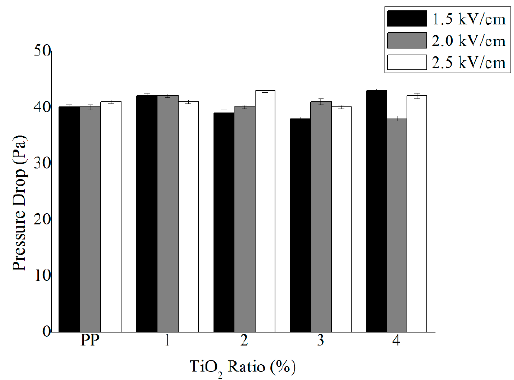
Figure 7. Pressure drop of electret melt-blown fabrics as related to the ratio of TiO 2 (1, 2, 3, and 4 wt%) and electric field intensities of (a) 1.5, (b) 2.0, and (c) 2.5 kV/cm. The pressure drop of non-electret pure PP melt-blown fabrics is 40 ± 0.5 Pa.